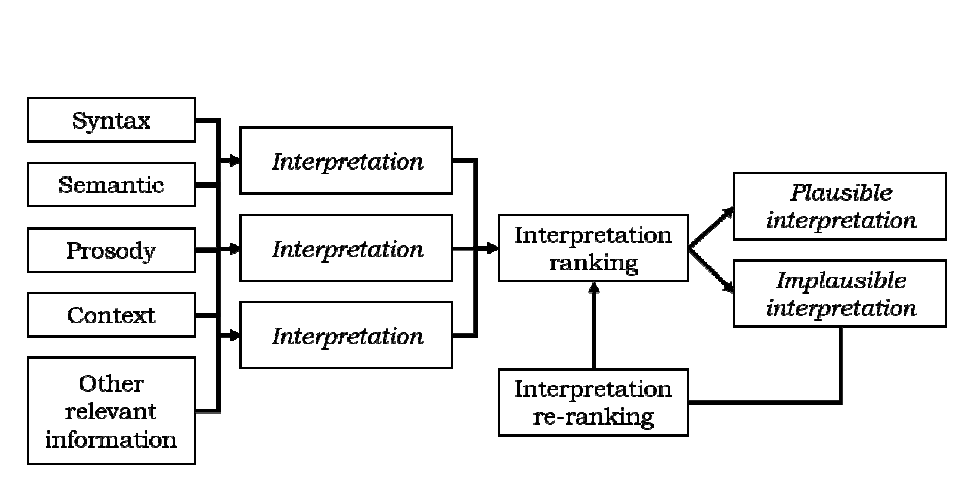
Figure 2. Constraint-based